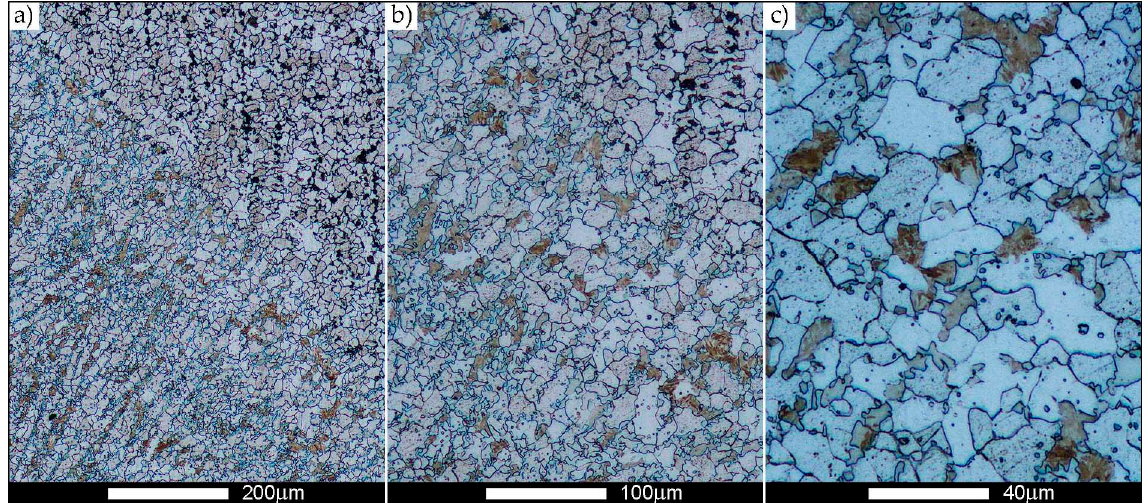
Figure 52. Welded joint microstructure of Hardox 450 steel with visible prior austenite grain boundaries, austenitised at 900 °C—FL zone shown in Figure 2. ( a ) 100×; ( b ) 200×; ( c ) 500×.